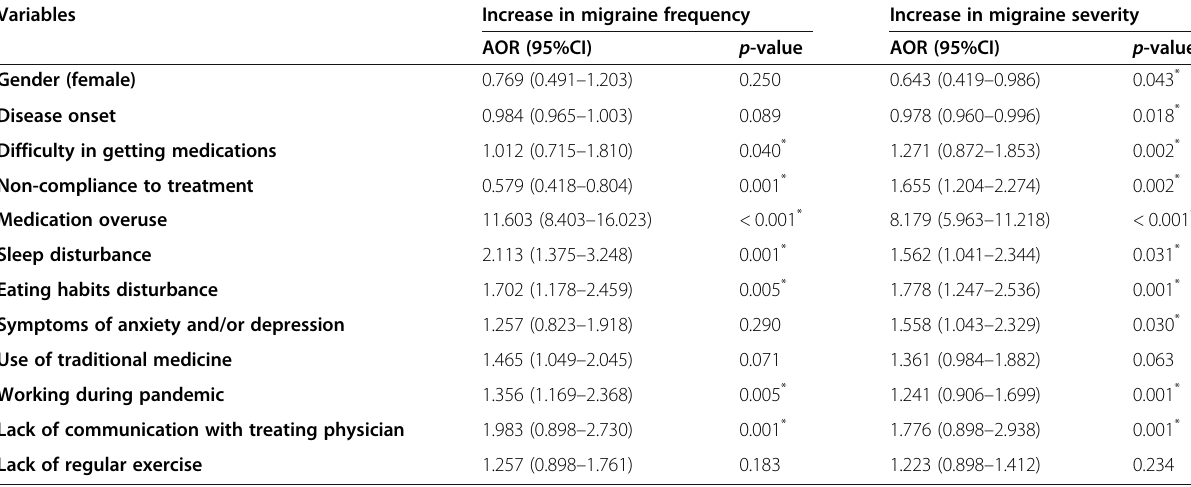
Table 3 Multivariate logistic analysis to identify independent variables affecting increase in migraine frequency and severity (n = 1018)